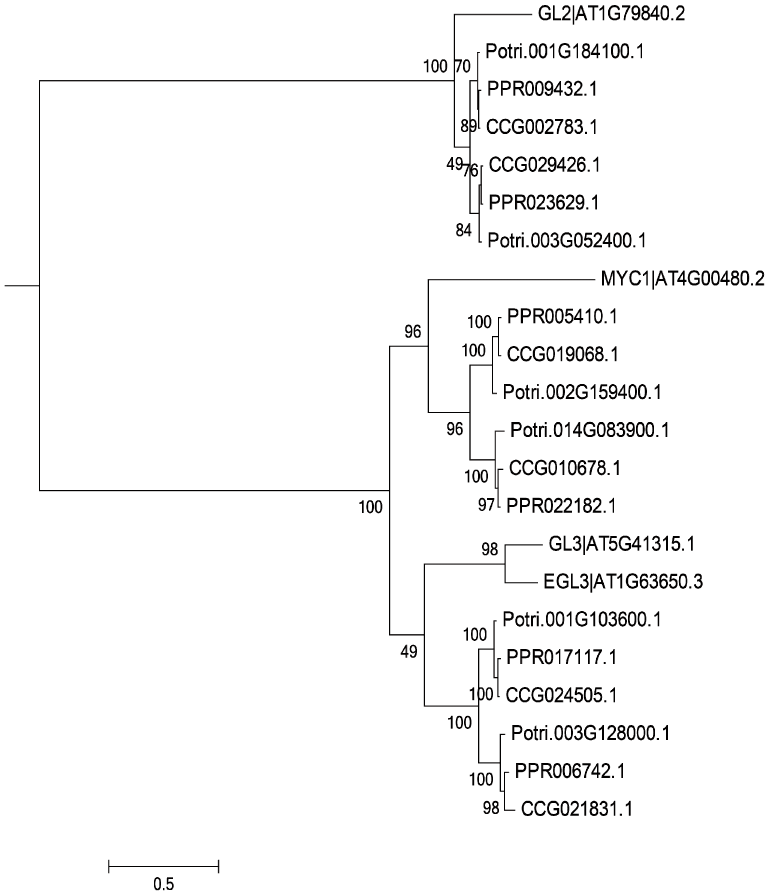
Figure 3. Phylogenetic relationships of basic helix ‐ loop ‐ helix (bHLH) TFs (except for GL2) from Arabidopsis , P. trichocarpa , P. pruinosa , and P. euphratica . The phylogenetic tree was built using the maximum likelihood method implemented in RAxML. Homology of genes between Arabidopsis and the three poplars was confirmed using the tree.